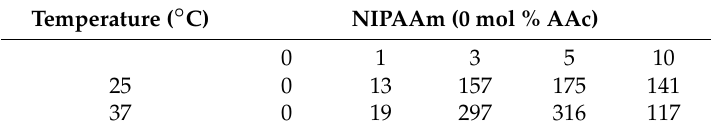
Table 6. Variations of ∆ SR (%) for different hydrogels tested at pH = 4, 7.4 and 10.